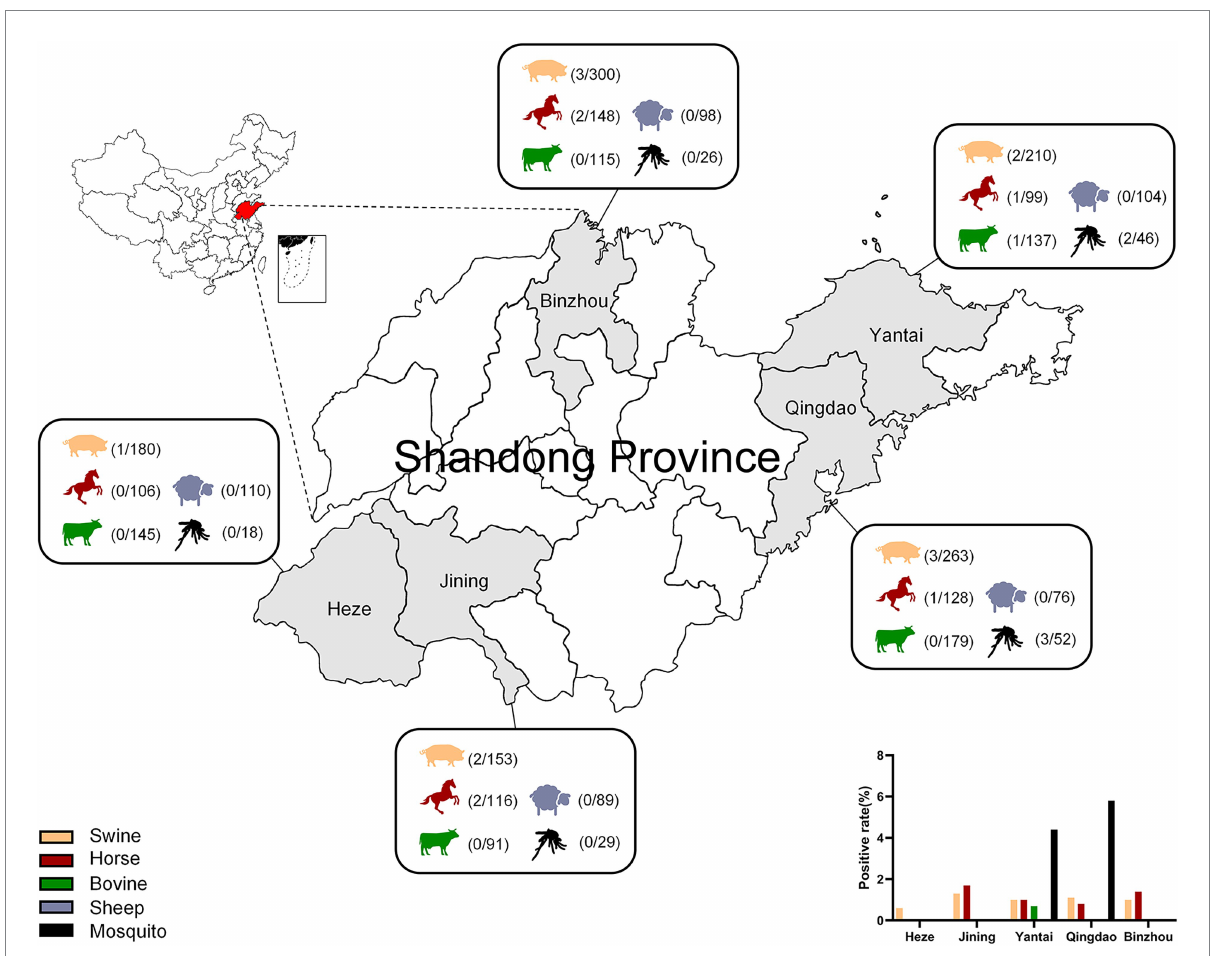
FIGURE 4 Serum samples of swine, bovine, horse, sheep, and mosquito samples from Heze, Jining, Yantai, Qingdao, and Binzhou in Shandong Province, China, were collected for RT-qPCR and the positivity rate of each animal was